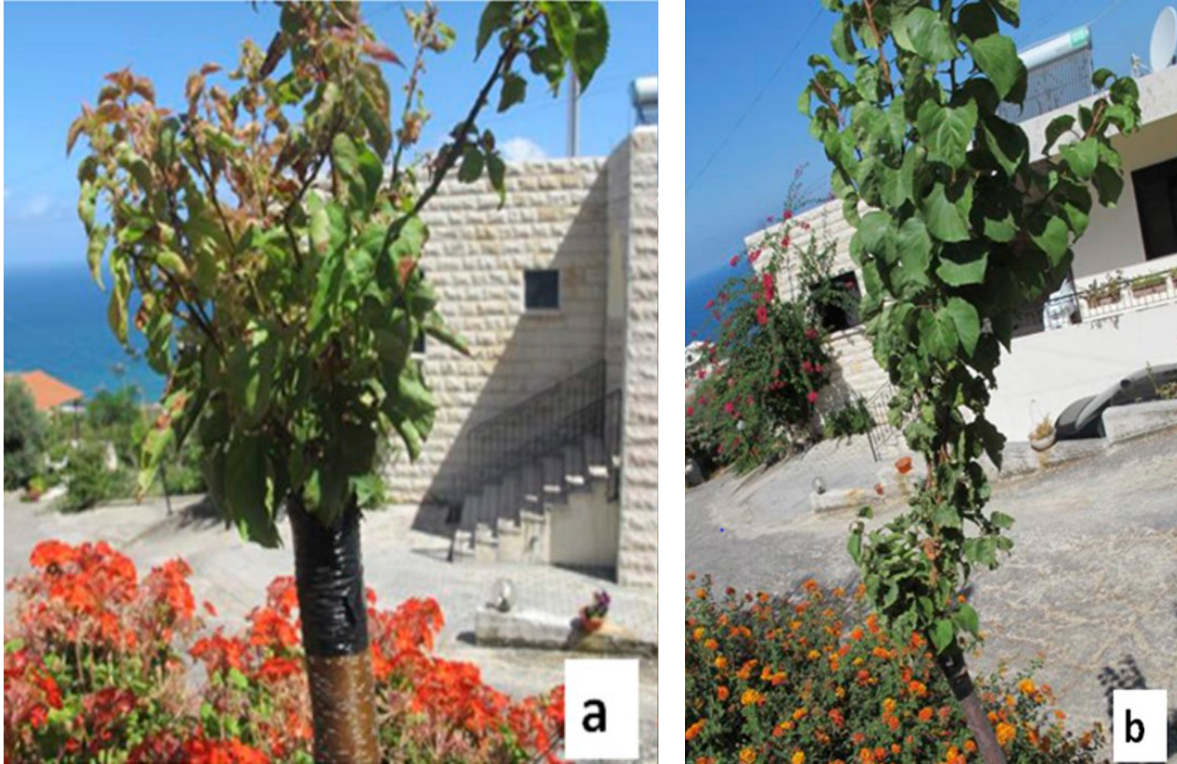
Figure 3. ‘Ca. P. phoenicium’-infected almond rootstocks in the field, grafted with Apricot Farclo scions. In June 2013, the growth from scions showed clear symptoms of proliferation (a). The same tree in September, when the remission from symptoms was observed